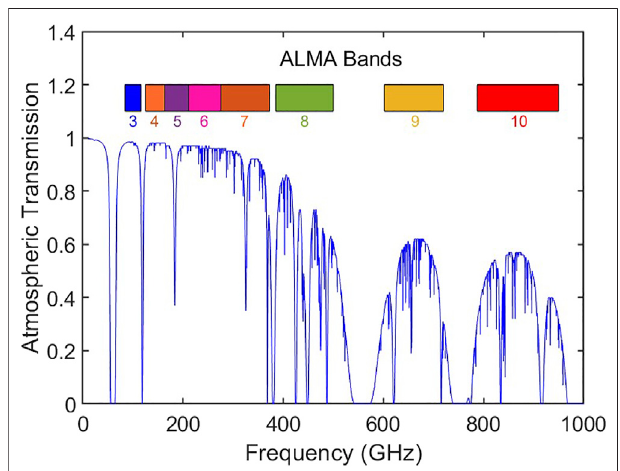
FIGURE 5 | Zenith atmospheric transmission of H 2 O vapor of the ALMA telescope with precipitable H 2 O vapors of 0.5 mm simulated from the Atmospheric Transmission at Microwaves model described by Pardo et al. (2001). Further information may be found in the work of Maiolino